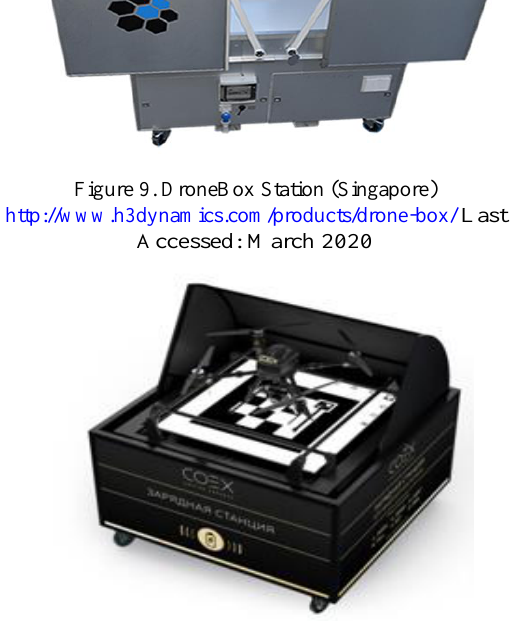
Figure 10. Copter Express Charging Station (Russia) https://copterexpress.ru/pelican. Last Accessed: March